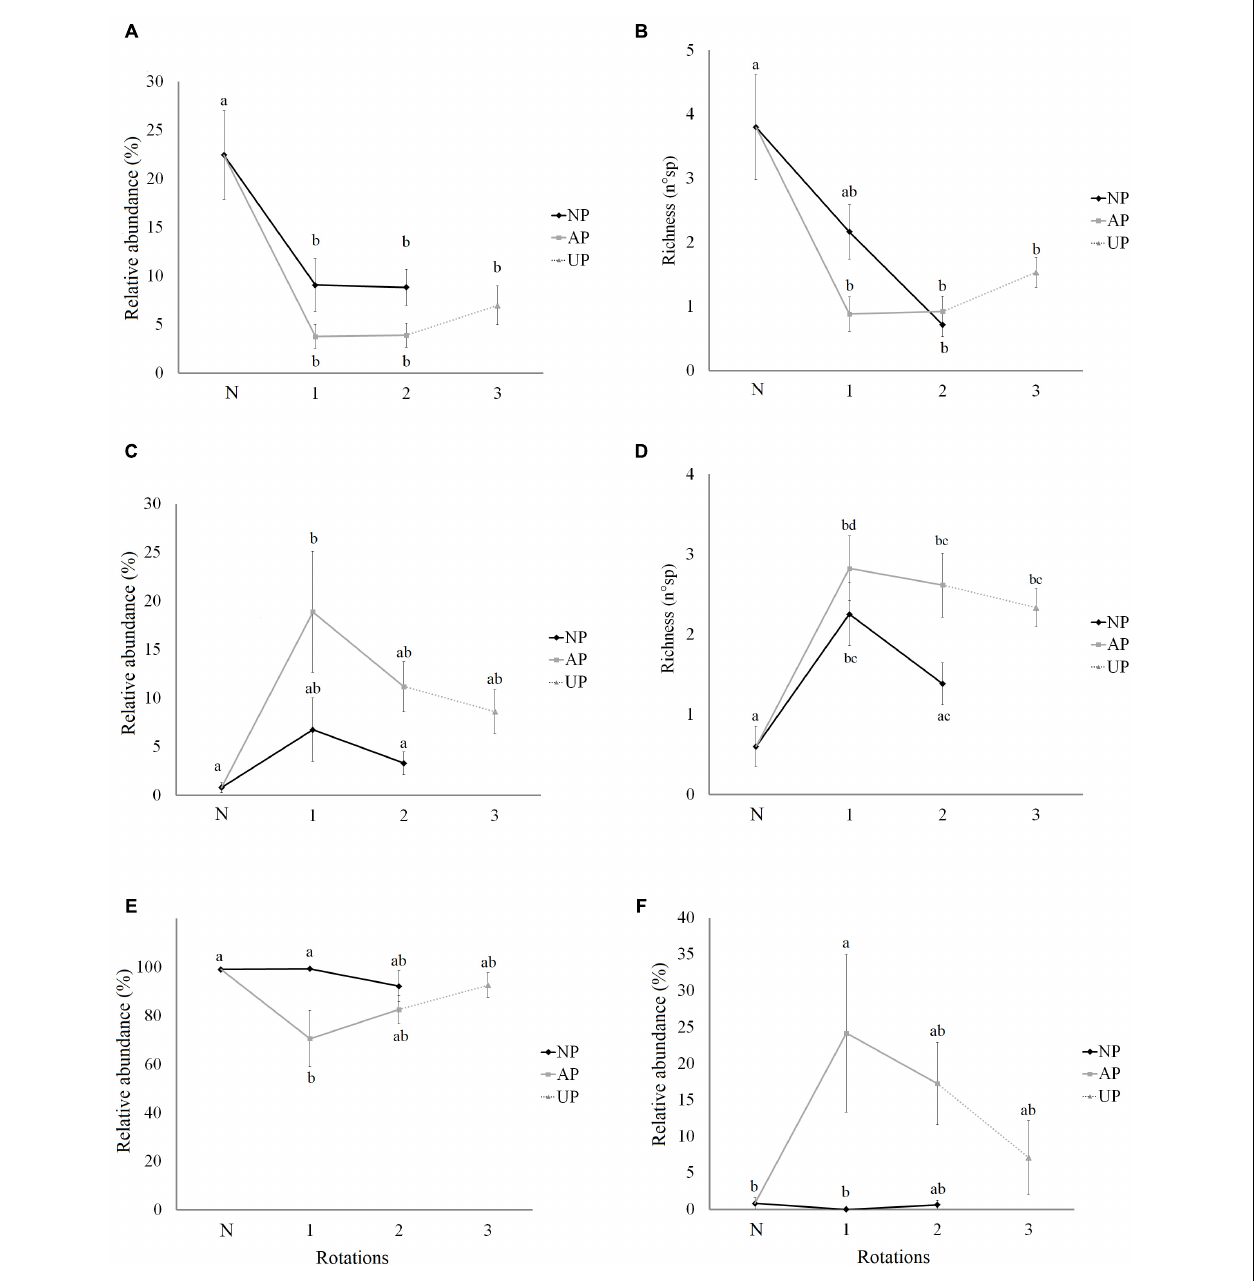
FIGURE 4 | Relative abundance and richness of plants in the understory of native forests and pine plantations with different origin and number of rotations. (A) Abundance of hygrophilous woody plants. (B) Richness of hygrophilous woody plants. (C) Abundance of exotic woody plants. (D) Richness of exotic woody plants. (E) Abundance of native herbs. (F) Abundance of exotic herbs. N in x -axis is Native forest. NP, native forest transformed into pine plantation, AP, agricultural land transformed into pine plantation, UP, unknown previous land use (assumed as agricultural land) transformed into pine plantation. Lower case letters indicate the significance of differences among categories obtained by BH multiple